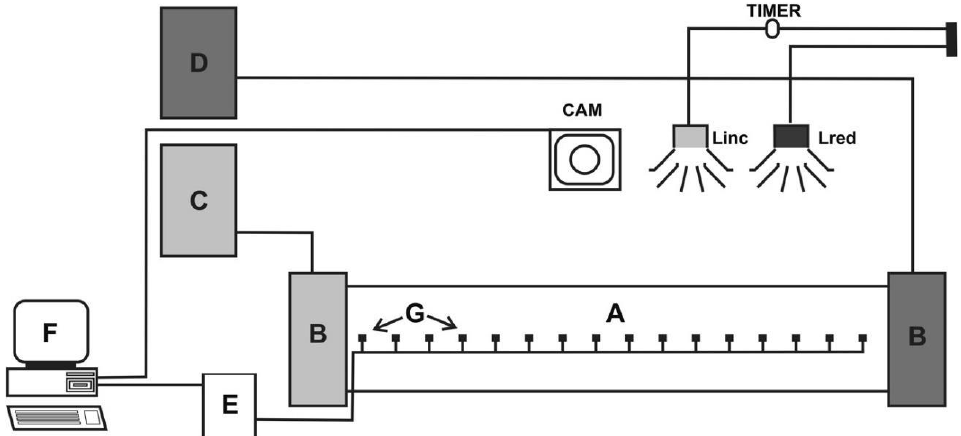
Figure 1. Experimental set-up for the recording of thermoregulatory behaviour [18]. A — thermal gradient chamber; B — fluid chambers; C — cryostat; D — thermostat; E — recording keeper; F — computer; G — thermocouples; Linc — white light; Lred — red light; CAM — video camera.